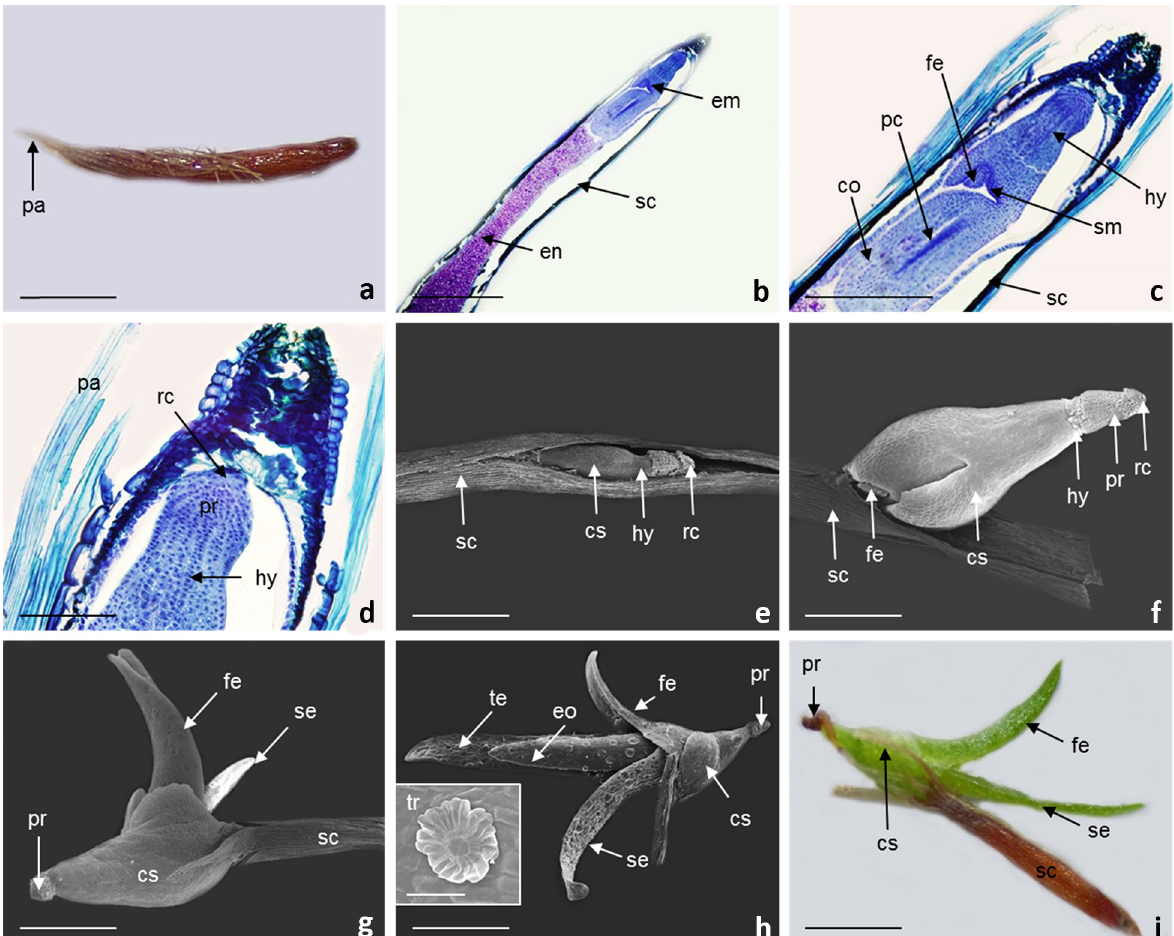
Figure 2. Seed morphology and post-seminal development of Vriesea bahiana. a) Mature seed, showing a plumose appendage. b- i) Phases of post-seminal development observed by light microscopy (b, c, d, i) and scanning electron microscopy (e, f, g, h). b- d) Start of germination, where it is possible to observe the presence of the haustorial cotyledon inside the seed coat, in contact with the endosperm, along with a well-defined procambium and small vestigial primary root and the presence of the root cap. e) Germination observed on day 7 from the end of the plumose appendage, with emergence of the still rudumentary primary root and exposure of the cotyledon sheath. f) Germination on day 12, showing the emergence of the first eophyll. g- i) Germination on day 15, showing the second eophyll and first scale-like trichomes on the surface of the leaf epidermis, more intense in the other eophylls. (co) cotyledon; (cs) cotyledon sheath; (em) embryo; (en) endosperm; (eo) eophyll; (fe) first eophyll; (hy) hypocotyl; (pa) plumose appendage; (pc) procambium; (pr) primary root; (rc) root cap; (sc) seed coat; (se) second eophyll; (sm) shoot tip meristem; (te) third eophyll; (tr) trichome. Bars: a- d = 0.2 cm; e- i = 500